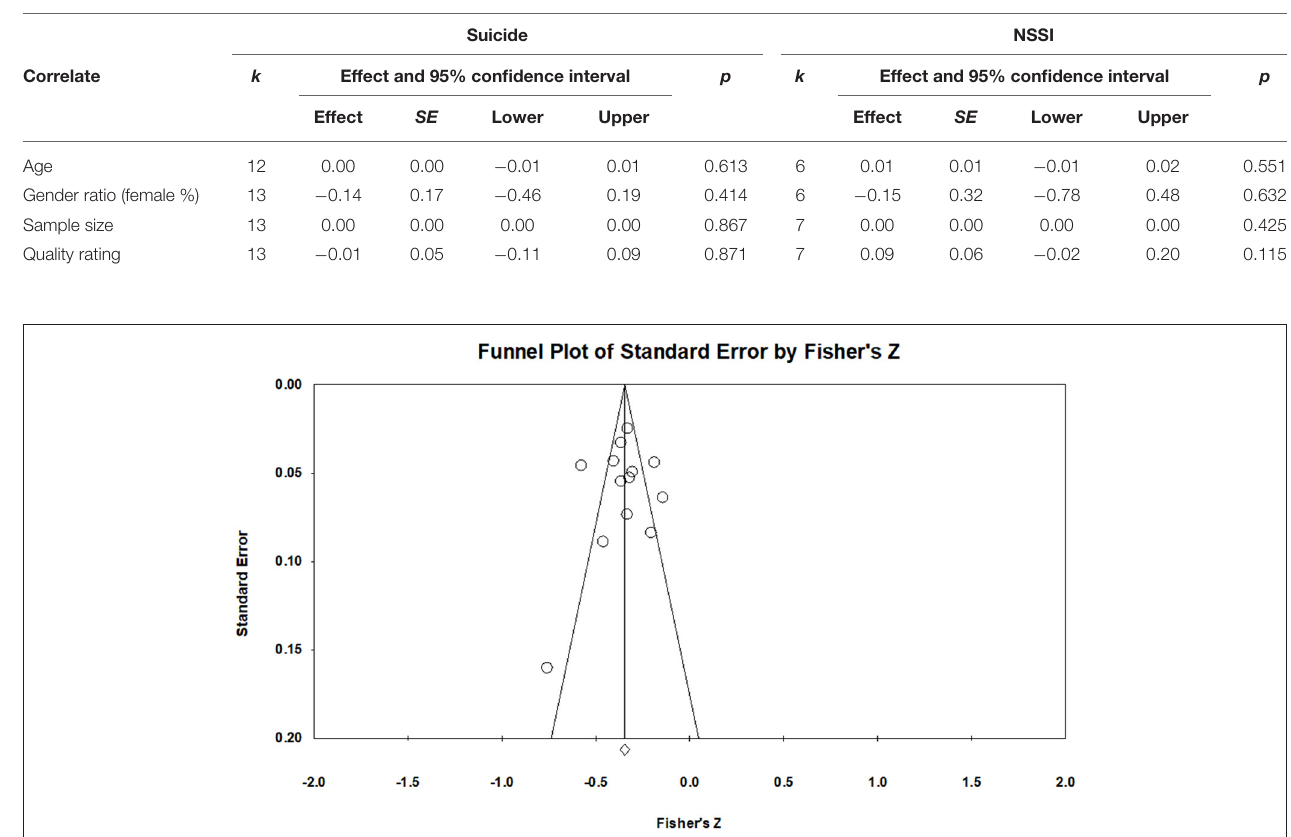
TABLE 5 | Regression analysis results by age, gender ratio, sample size, and quality assessment rating.